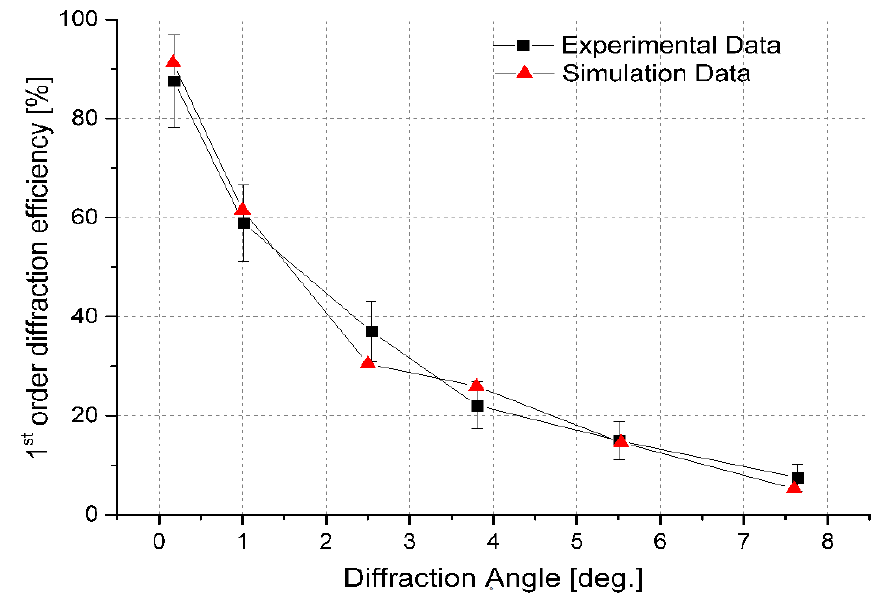
Figure 8. Experimentally and simulated DE of a LC-based BD cell as a function of the diffraction angle. The square and triangle denote the experimental and simulation data, respectively. The error bars are used to indicate the errors which are calculated by dividing the standard deviation by the square root of the number of experiment measurements.